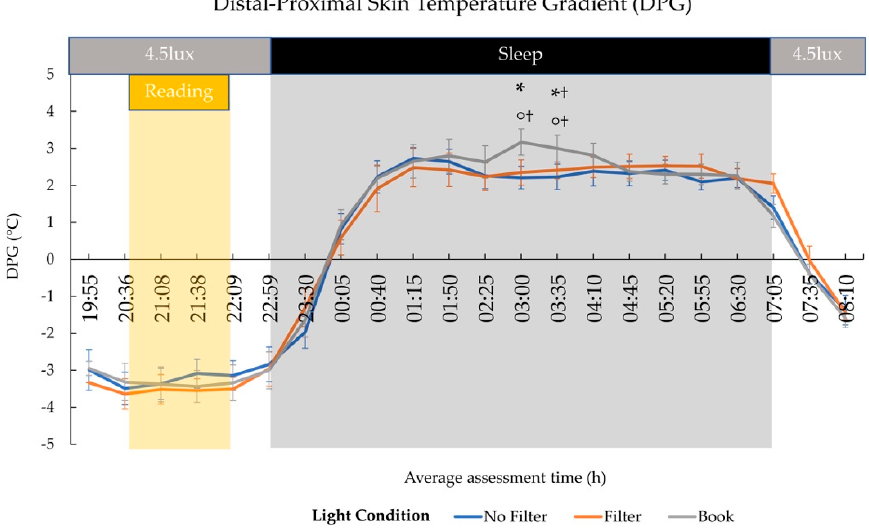
Figure 4. Time Course of Distal-Proximal Skin Temperature Gradient (DPG) values (mean and standard error). The 4.5 lux label corresponds to the background room lighting and refers to photopic lux. During the 8 h sleep interval, lights were switched off (0 lux). DPG was higher in the “Book” compared to the “No Filter” condition and by trend higher in the “Book” than in the “Filter” condition around 03:00 and 03:35 during the night. Values are averaged around the depicted time points ± 15 min, which refer to the administration points of the KSS and saliva samplings during the evening and morning. * = p ≤ 0.05; ◦ = p ≤ 0.10; † = p adj . >